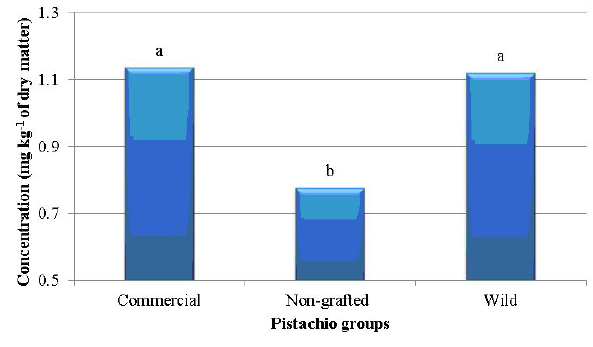
Fig. 10. The strontium concentration of three Iranian pistachio groups. (Each column with different letters is significantly dif- ferent (P <